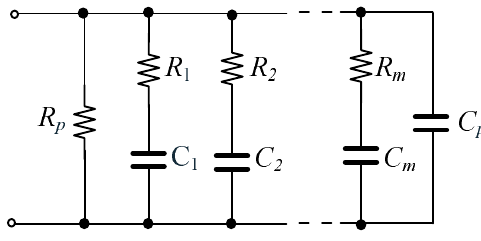
Figure 3. RC network for approximating the behavior of fractional-order capacitors (2) [47].